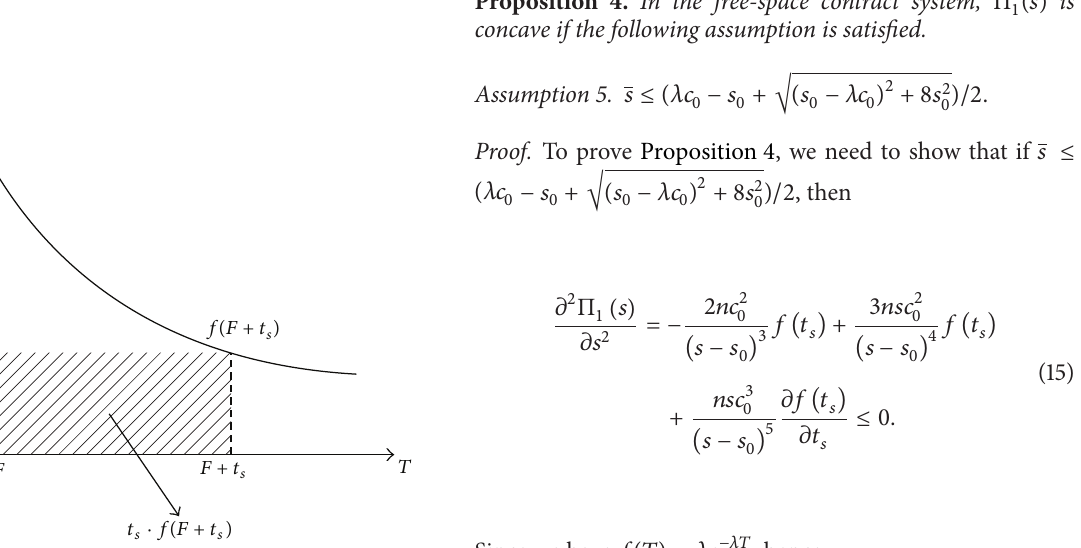
Figure 2: The container dwell time